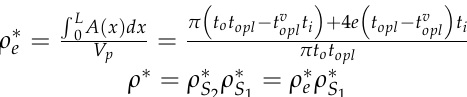
Figure 2. Hollow, variable-section element cross sectional attributes and swelling-to-length e / L characteristics ( a ). Finite-element unit-cell square ( b ), honeycomb ( c ) and re-entrant star-shaped ( d ) variable-section element lattices with t o = t opl = 1 mm, e = 0.5 mm and an element length L of 20 mm. Periodic multiscale honeycomb FEM with a uniaxially loaded deformed cell is provided in ( e ).